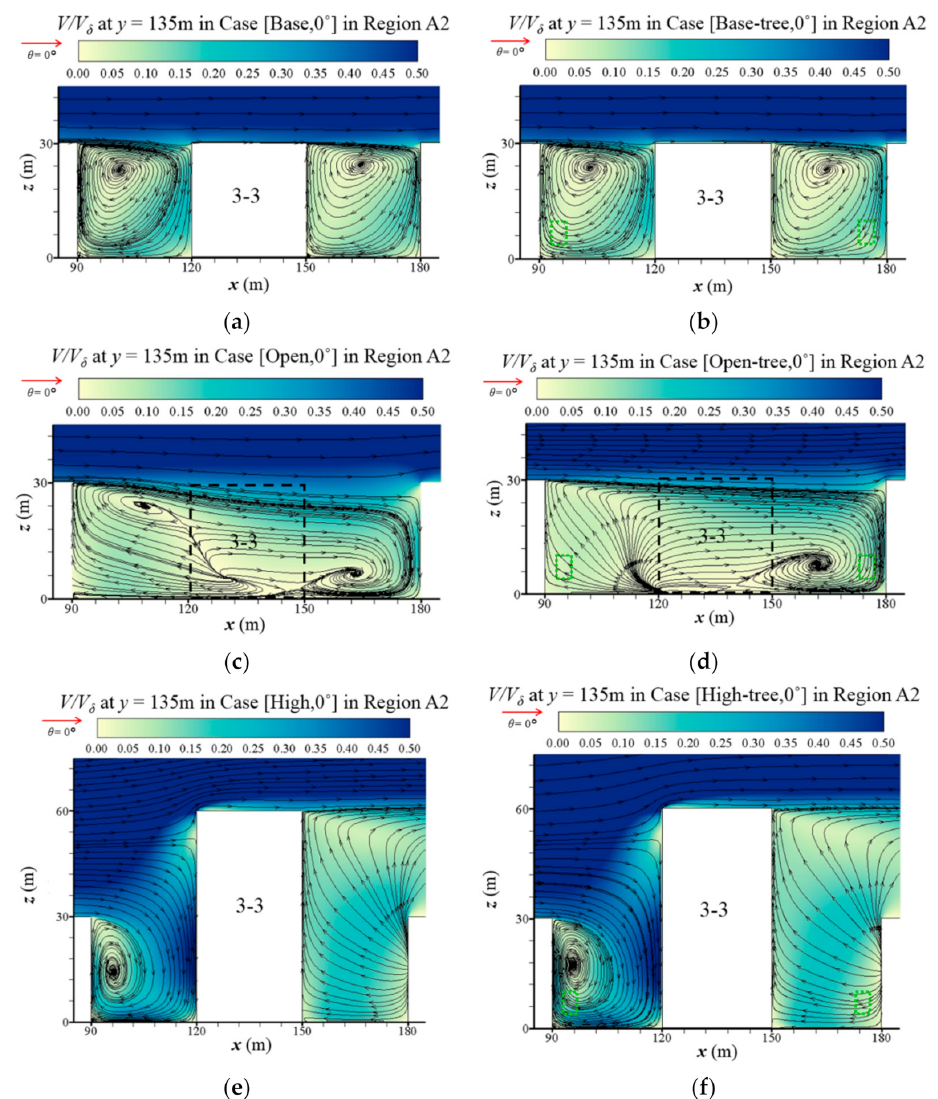
Figure 4. Normalised velocity ( V/V δ , V δ = 4.34 m/s) at vertical plane ( y = 135m) in Region A2 in ( a ) Case [Base, 0 ◦ ], ( b ) Case [Base-tree, 0 ◦ ], ( c ) Case [Open, 0 ◦ ], ( d ) Case [Open-tree, 0 ◦ ], ( e ) Case [High, 0 ◦ ] and ( f ) Case [High-tree, 0 ◦